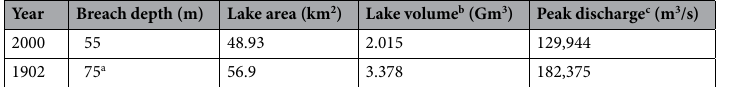
Table 4. Basic parameters of the Yigong barrier lakes 15 and estimated peak discharges of associated outburst floods in 1902 and 2000 AD. a It is assumed that the breach depth is equal to the minimum dam height given by Shang et al. 12 . b Volume calculated using V = A discharge calculated using Q p = 3.85 ∗ ( H ∗ V )